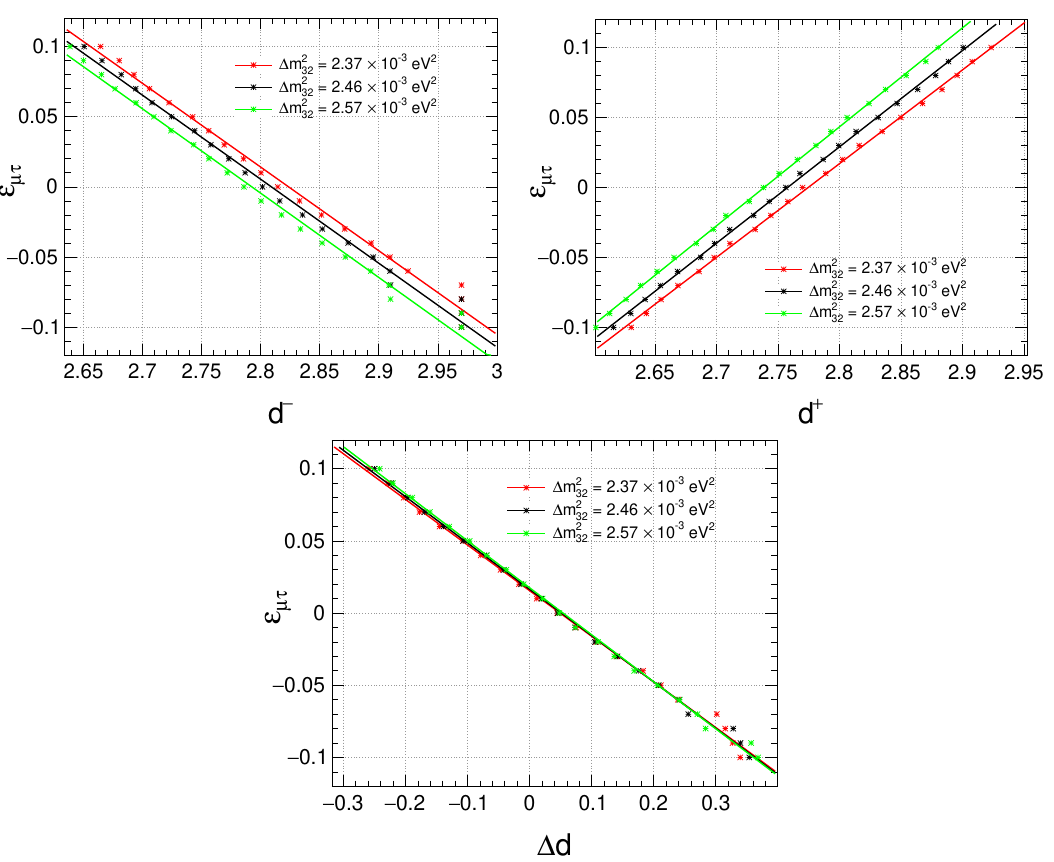
Figure 6 . Upper panels: the calibration of ε µτ with the dip location in U/D ratio of µ − (left panel) and µ + (right panel) events separately. Lower panel: the calibration of ε location of µ − and µ + . Note that for − 0 . 1 < ε